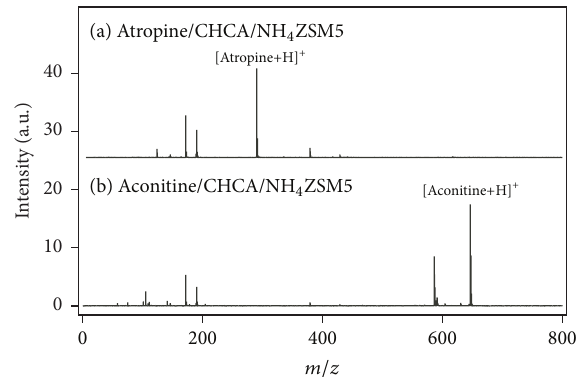
Figure 3: Mass spectra of (a) atropine and (b) aconitine measured with CHCA/NH 4 ZSM5.